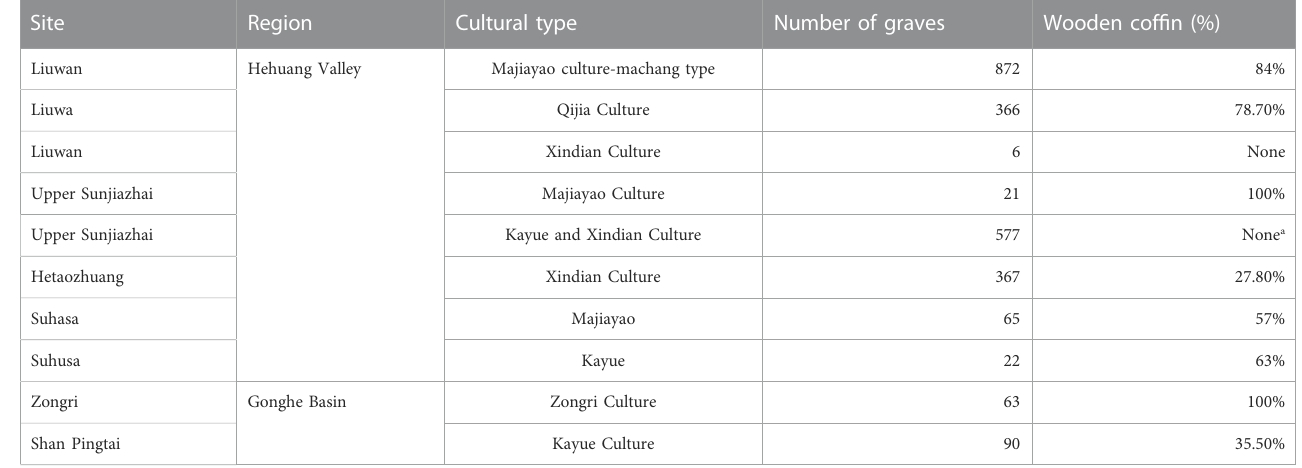
TABLE 3 Use of wood cof fi n in the Northeast Tibetan